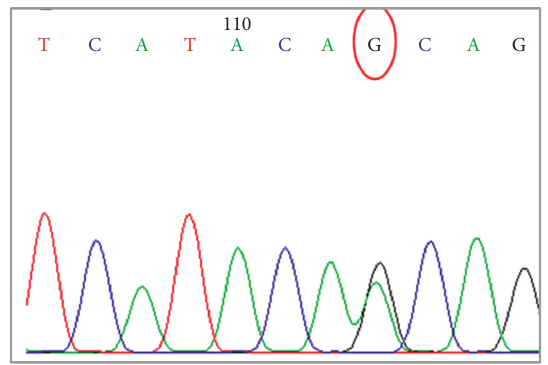
Figure 2: Chromatogram of single-nucleotide changes ( G > A) in the SCN1A gene (rs2298771).